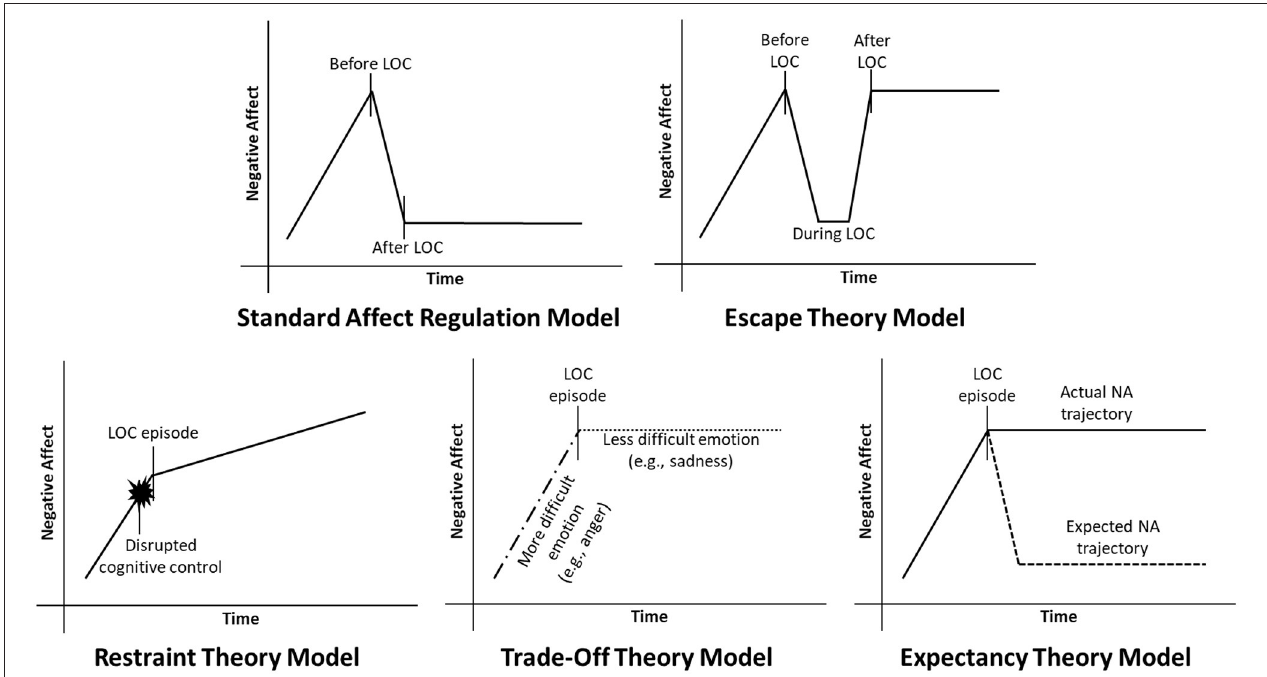
FIGURE 1 | Current affect regulation models of negative affect (NA) and loss of control eating (LOC). In the standard affect regulation model, NA increases prior to LOC, and decreases following LOC. Conversely, escape theory predicts that NA decreases while LOC is in progress, but increases to pre-LOC levels after LOC. Restraint theory predicts that NA disrupts the cognitive control required to maintain dietary restraint, leading to LOC. Trade-off theory predicts that LOC replaces one negative emotion (e.g., anger) with another that is less aversive (e.g., sadness). Finally, expectancy theory predicts that people engage in LOC because they expect to feel better afterwards, even though they may not actually feel